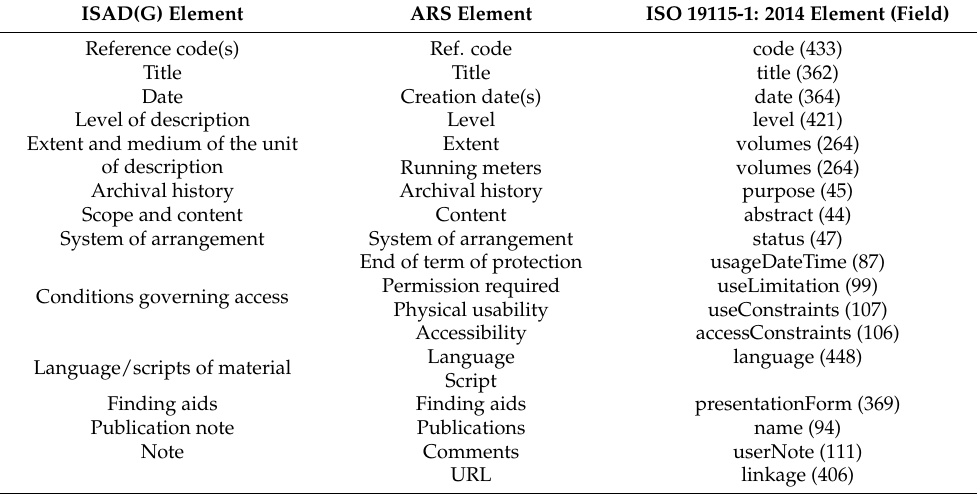
Table 2. Semantic mapping between ISAD(G) and ISO 19115-1: 2014 elements.